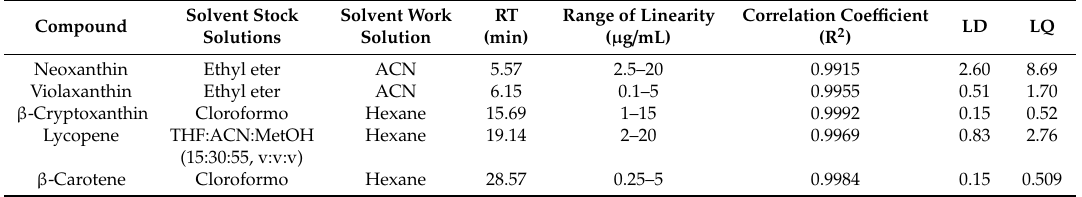
Table 1. Solubilization conditions, linearity and sensitivity parameters for carotenoid compounds analysed.